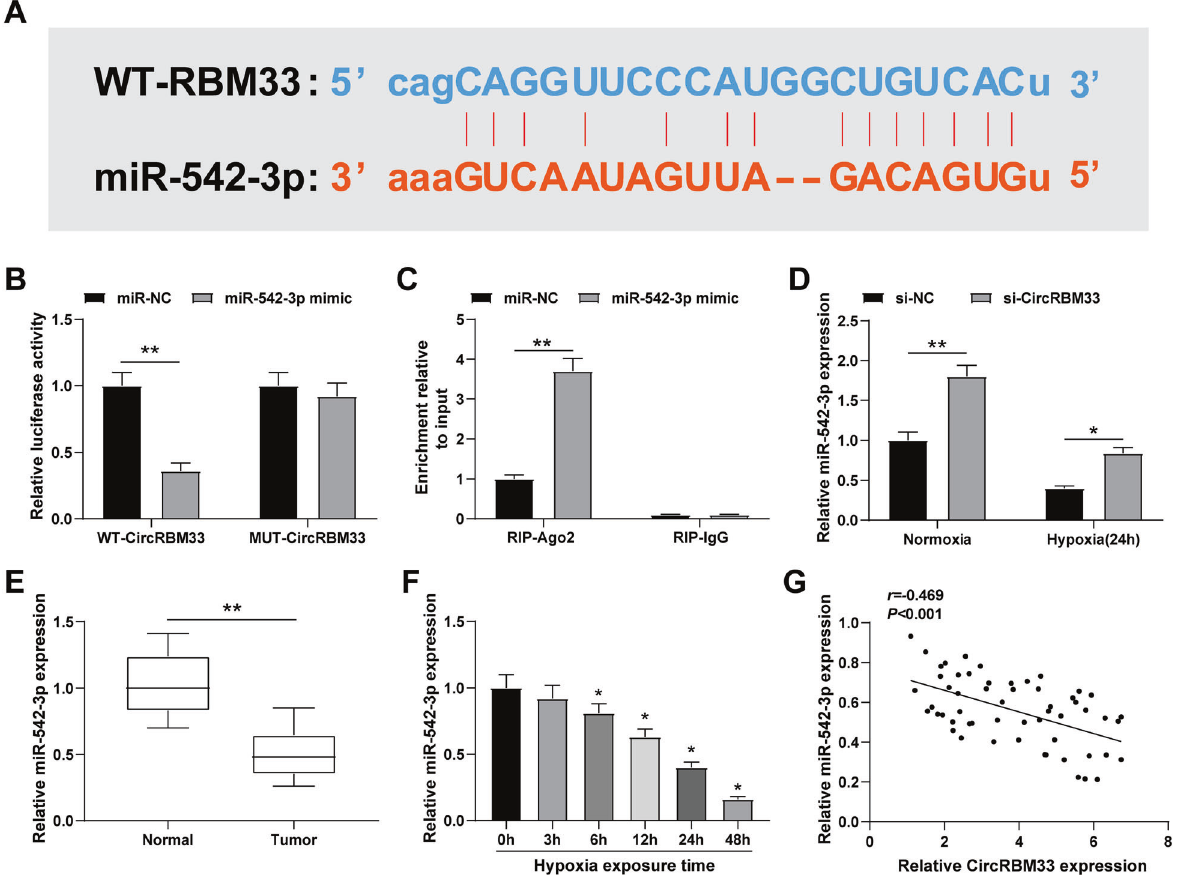
Fig. 4 CircRBM33 negatively regulates miR-542-3p expression. A StarBase database showed binding sites between circRBM33 and miR-542- 3p; B Dual luciferase reporter experiment con fi rmed the interaction between circRBM33 and miR-542-3p; C RIP experiment con fi rmed the interaction between circRBM33 and miR-542-3p; D MiR-542-3p expression after knocking down circRBM33; E miR-542-3p was downregulated in BCa tissues; F MiR-542-3p was downregulated in hypoxia-induced BCa cells; G. Pearson test analyzed the correlation between circRBM33 and miR-542-3p levels; ** P < 0.01; * P < 0.05. Data were expressed in the form of mean ± standard deviation (Repetitions = 3). The comparison between two groups should be performed by t test, that among multiple groups was by one-way ANOVA, while pairwise comparison was by Tukey ’ s method. The correlation was analyzed using Pearson correlation